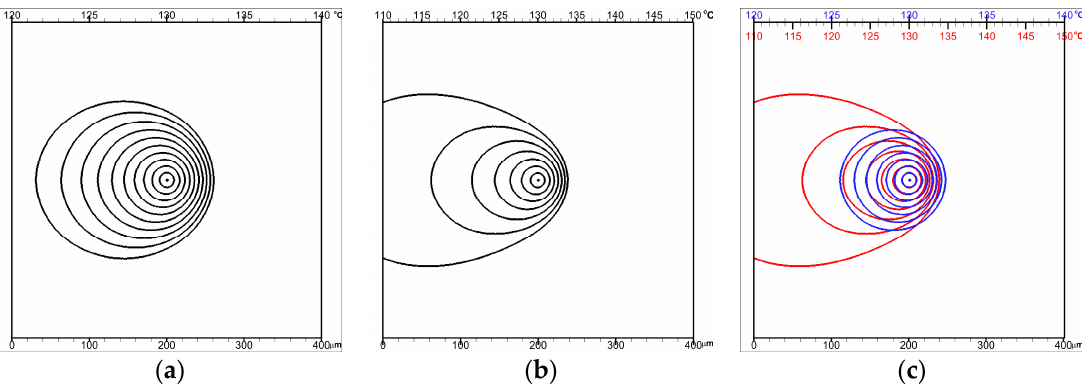
Figure 10. Spherulite shapes predicted by the particle level set method for different temperature gradient. The positions of spherulite growth fronts are plotted in 1-min intervals: ( a ) Λ = 50 ˝ C ¨ mm ´ 1 ; ( b ) Λ = 100 ˝ C ¨ mm ´ 1 ; and ( c ) shapes of the spherulites are different at the same moment.